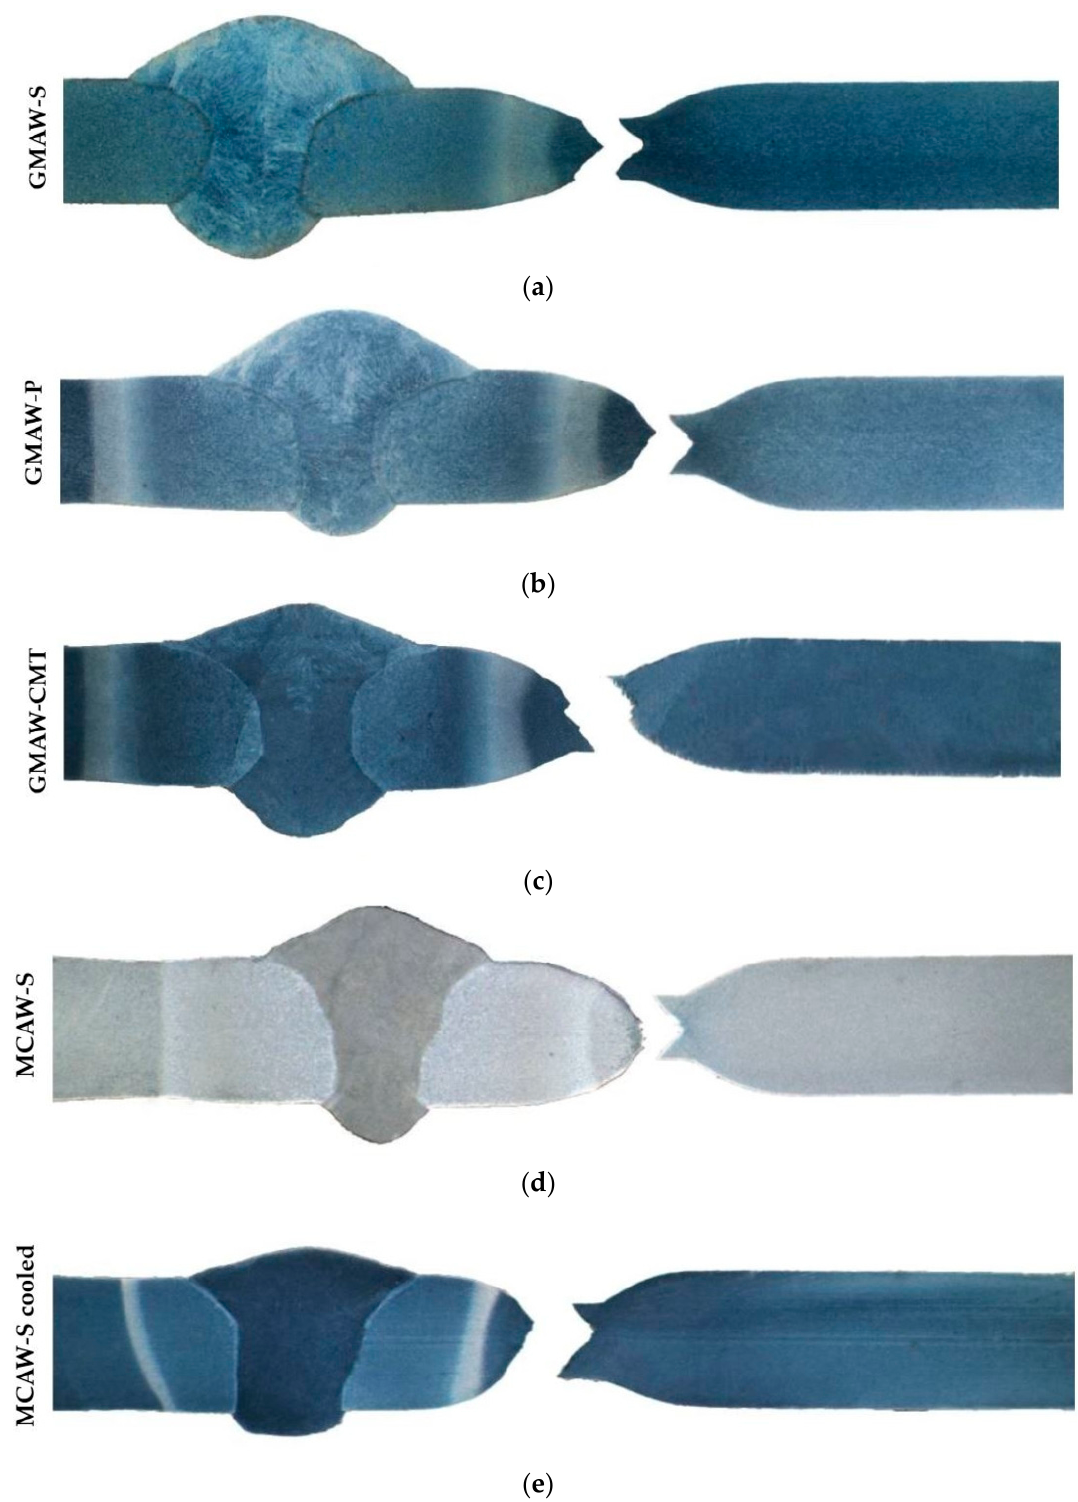
Figure 5. Fracture profiles made after the tensile test: ( a ) gas metal arc welding-short arc (GMAW-S), ( b ) gas metal arc welding -pulsed (GMAW-P), ( c ) gas metal arc welding-cold metal transfer (GMAW-CMT), ( d ) metal-cored arc welding-short arc (MCAW-S), and; ( e ) MCAW-S cooled. Table 6. Mechanical properties of the evaluated welded joints of S960MC steel.